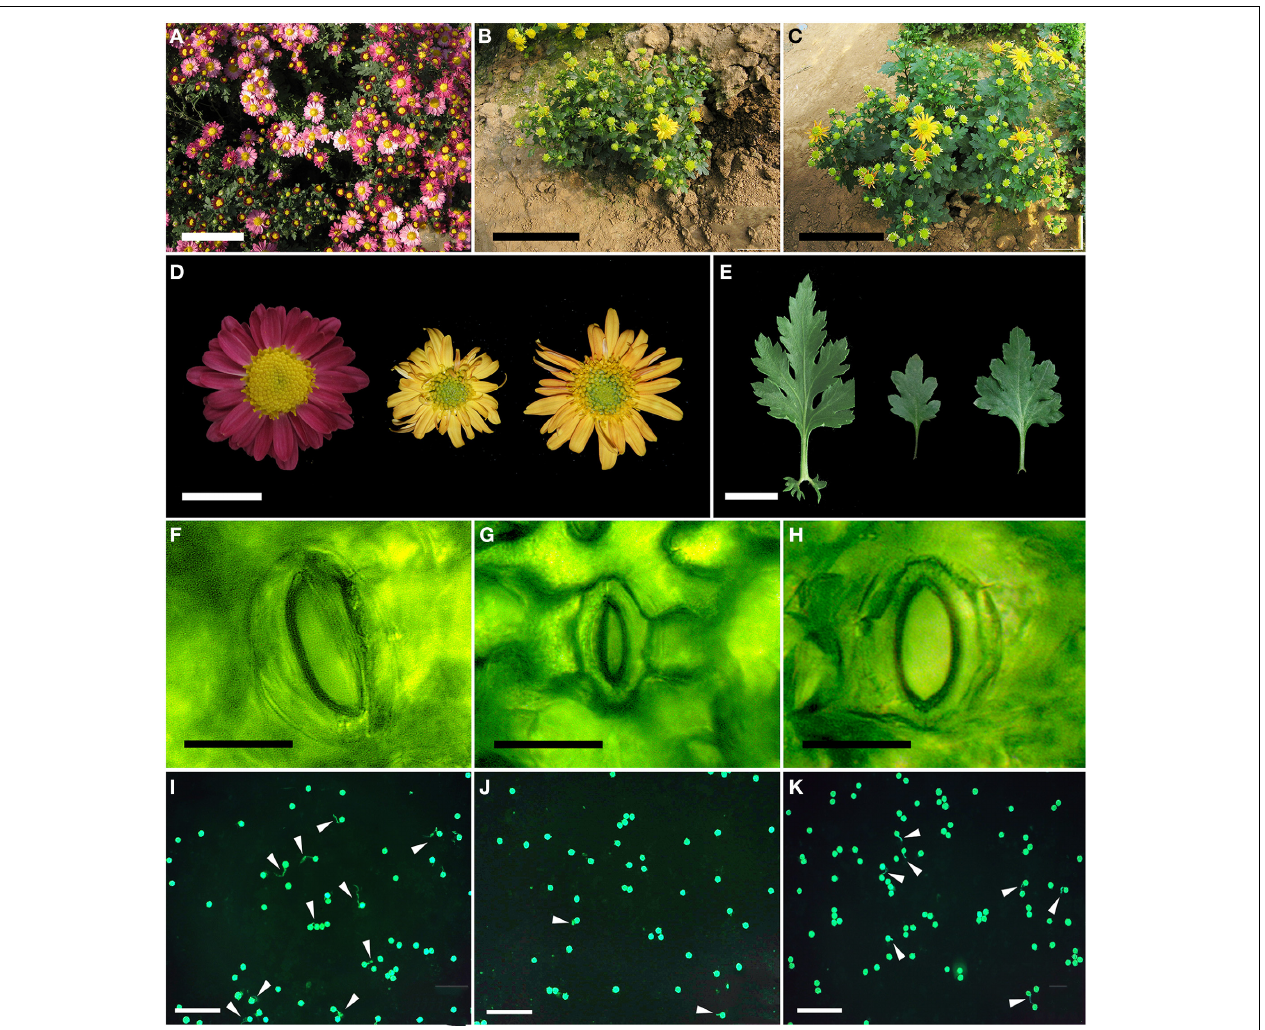
FIGURE 4 | Whole plant morphology of (A) cv. “Zhongshanzigui,” (B) the haploid, and (C) the doubled haploid plants. Bar: 10cm. (D) Leaf morphology of cv. “Zhongshanzigui” (left), the haploid (center) and the doubled haploid (right) plants. Bar: 2cm. (E) Flower morphology of cv. “Zhongshanzigui” (left), the haploid (center) and the doubled haploid